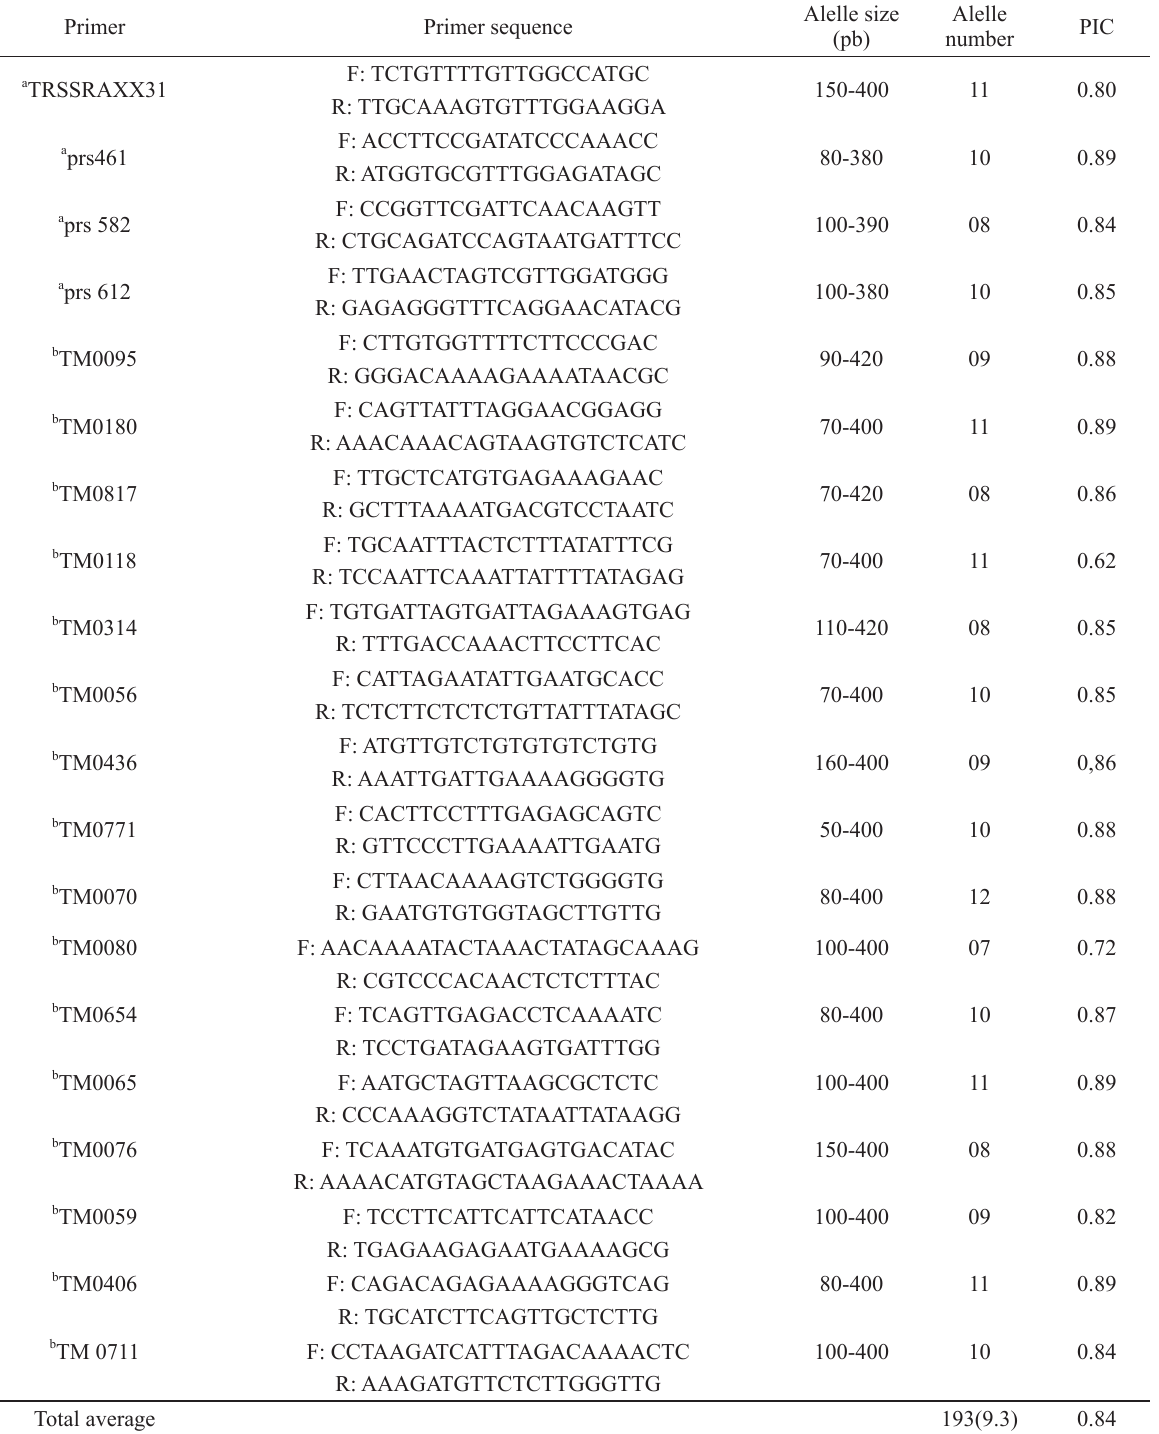
Characteristics of the 20 microsatellite marker used for T.